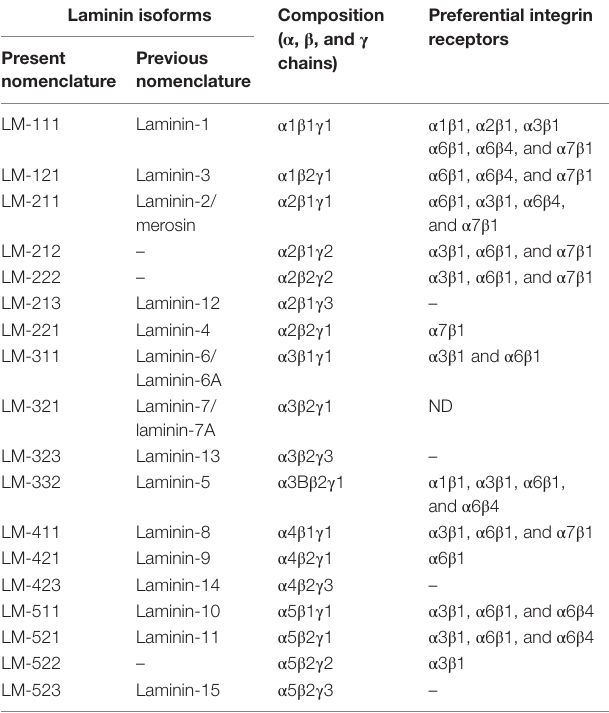
TABLe 1 | Laminin isoforms and corresponding integrin-type laminin receptors a . Laminin isoforms Composition